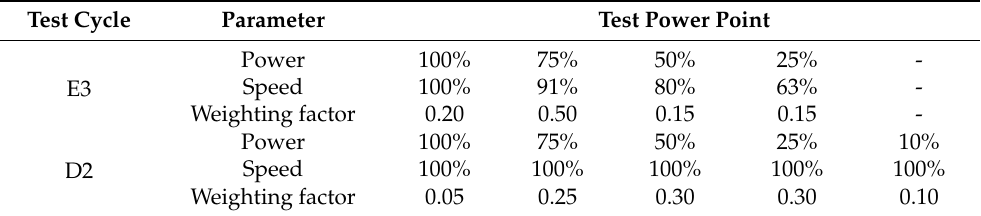
Table 1. Test cycle and weighting